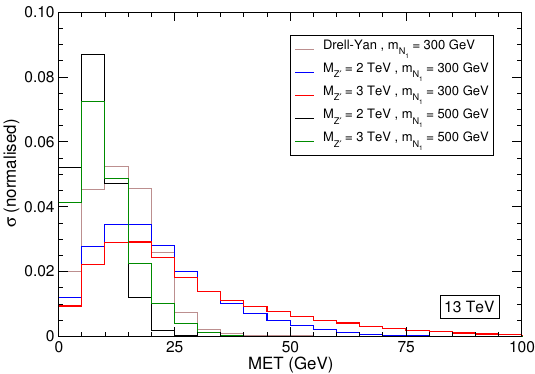
Figure 2 . Kinematical distributions of the missing energy (at parton level) in pp ! Z ( 0 ) ! N 2 N 2 . of the events one or two of the leptons can trigger the recording of the event (there are also two other leptons with identical distributions from the decay of the other N the signal e(cid:14)ciency would bene(cid:12)t from additional low-threshold four-lepton triggers. For illustration, we show in (cid:12)gure 2 the kinematical distribution of the missing energy (MET) computed at parton level, using the sum of the three-momenta of the two stable N anticipated, the missing energy is relatively